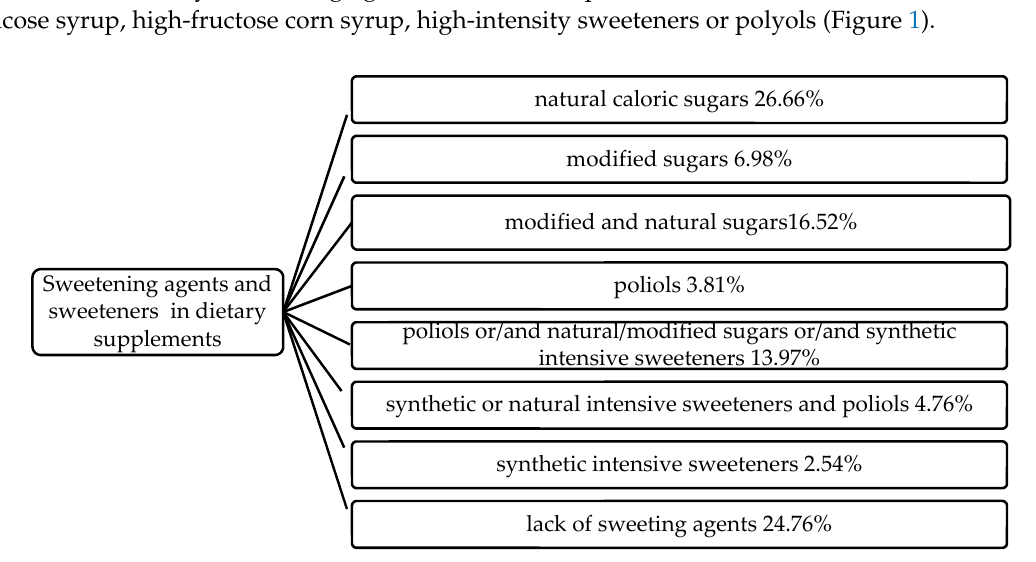
Figure 1. Combinations of sweetening agents and sweeteners in analyzed group of dietary supplements.